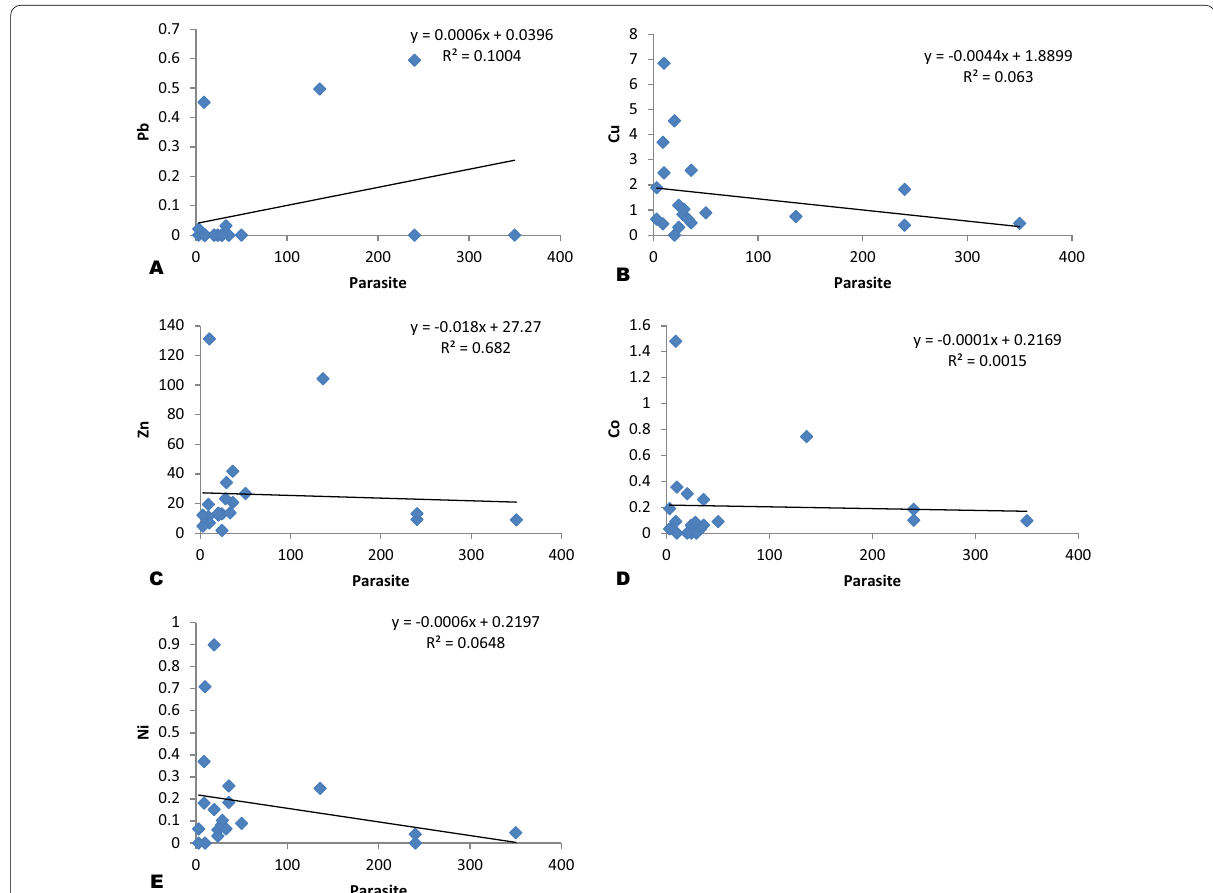
Fig. 4 Regression analysis of trace metal concentrations on the abundance of Cosmocerca sp. In the host toad. A B Regression analysis of copper, C =